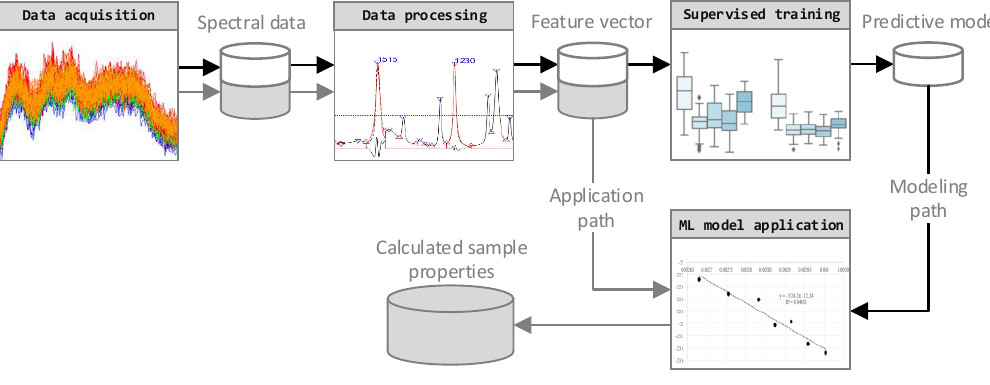
Figure 1. Data analysis and processing approach data flow chart. ML, Machine learning.